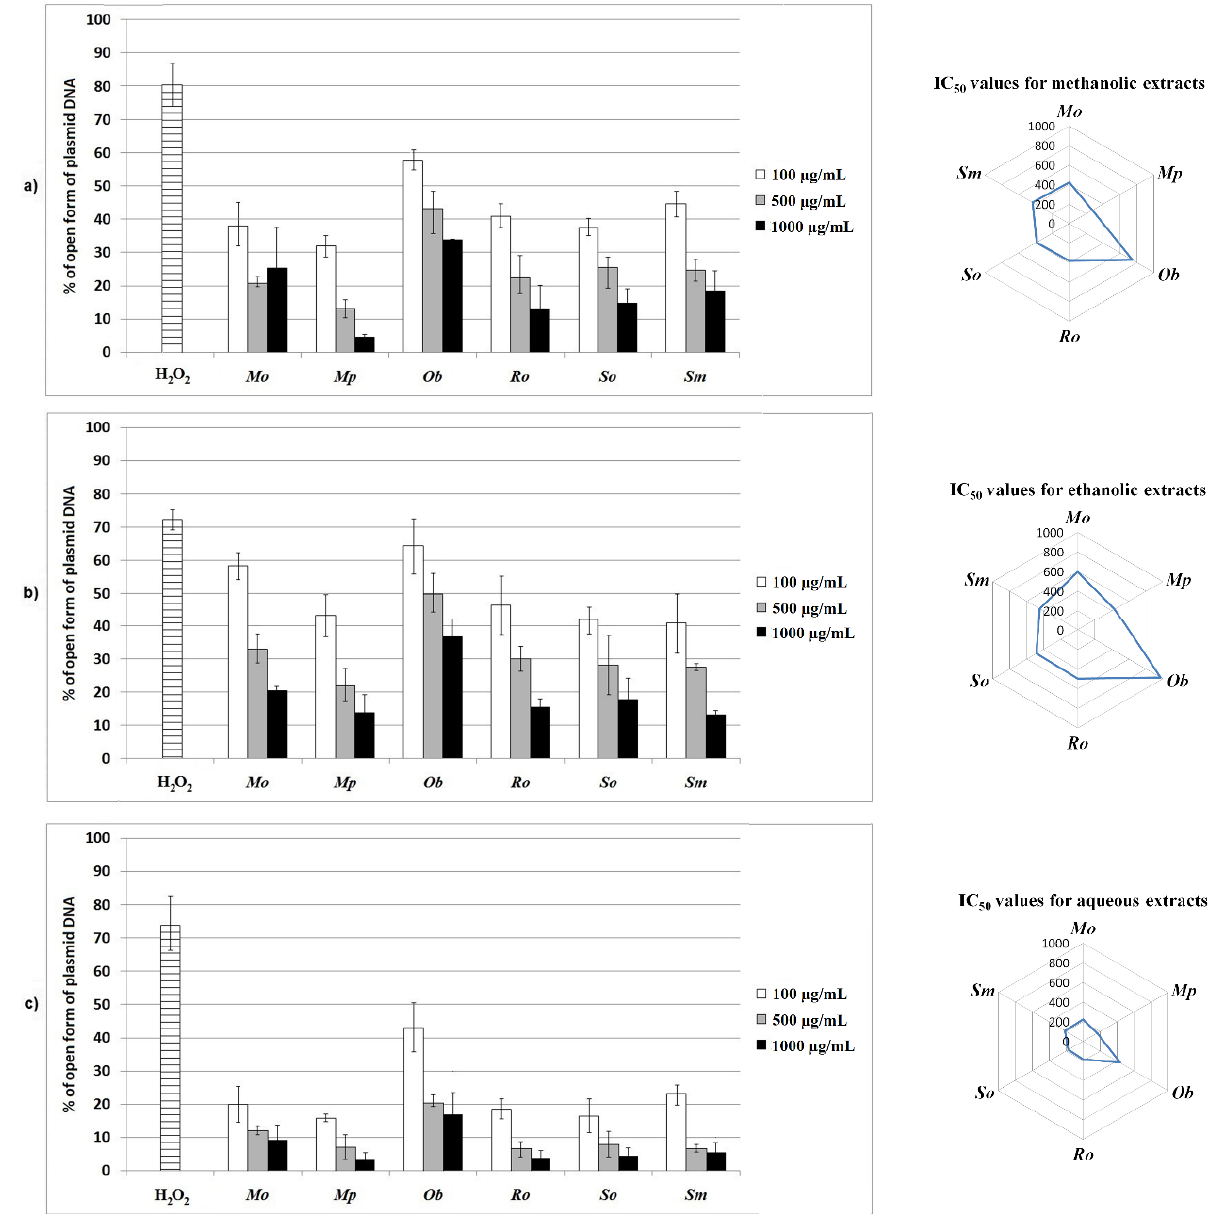
Figure 1. Percentage (%) of DNA damage (open form of plasmid DNA) in proportion to the concentrations of extracts (100, 500, and 1000 µ g/mL) and their IC 50 values ( µ g/mL). ( a ) Methanolic extracts; ( b ) ethanolic extracts; ( c ) aqueous extracts. H 2 O 2 —positive control. The level of statistical significance was set at p < 0.05.